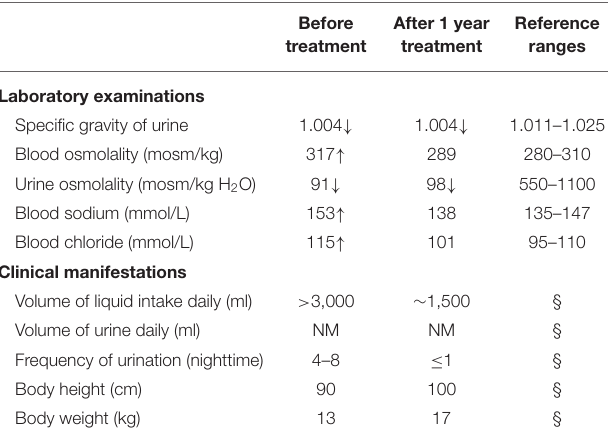
TABLE 1 | Changes of laboratory examinations and clinical manifestations after